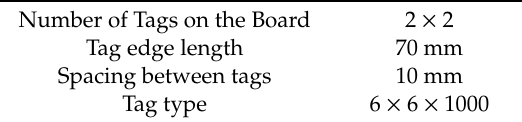
Table 1. Parameters of the 2D grid